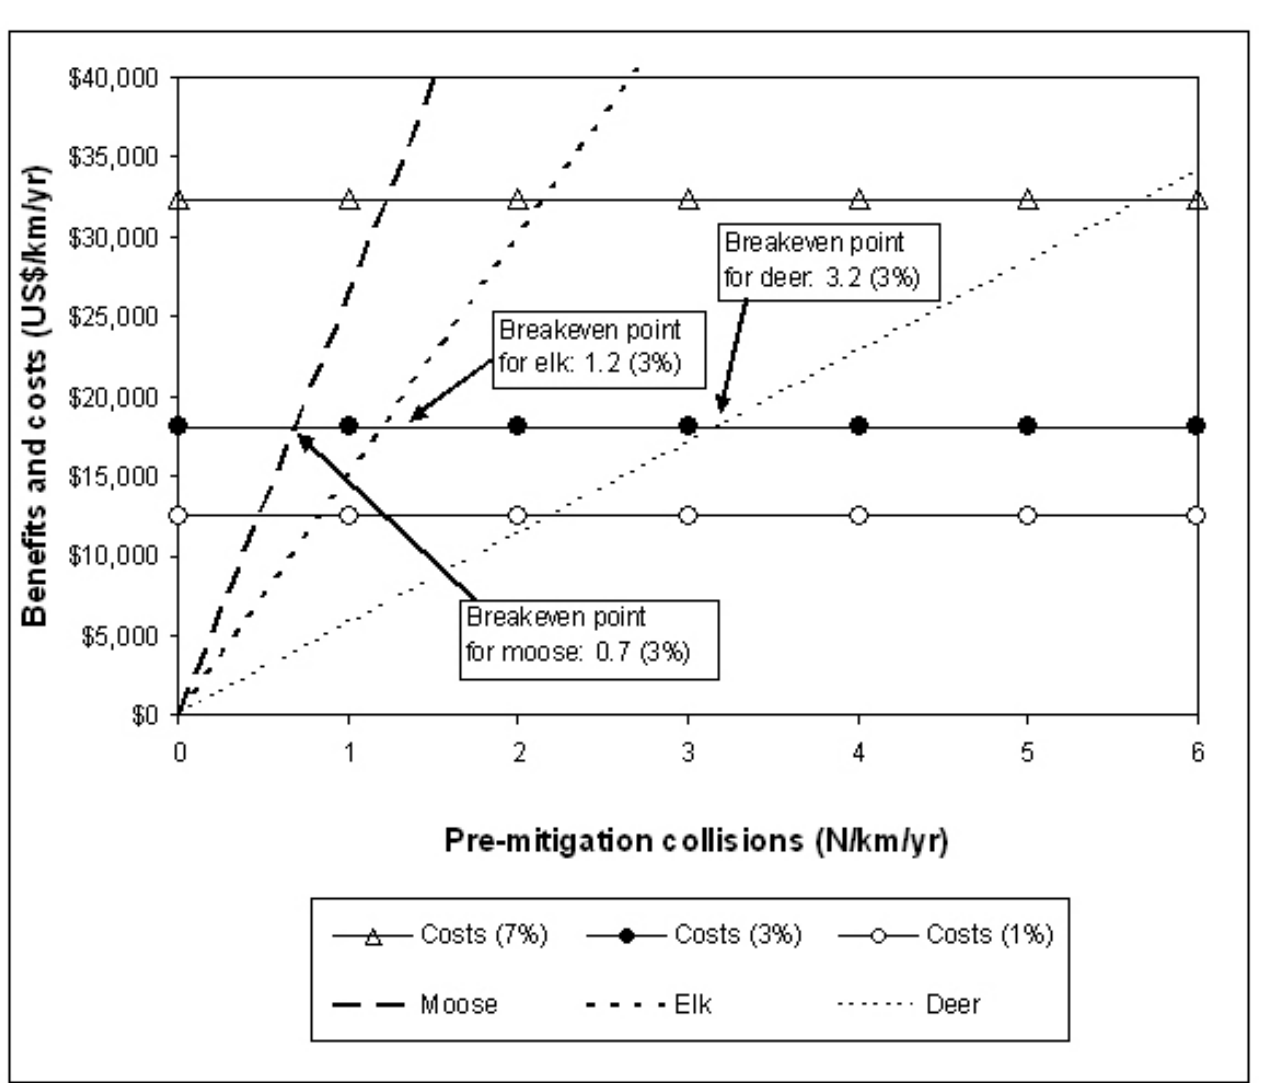
Fig. 6. The number of deer–, elk–, and moose–vehicle collisions per kilometer per year (dotted lines) needed to reach the threshold values (7%, 3%, and 1% discount rate) (in real 2007 US$) (solid lines) for fencing with